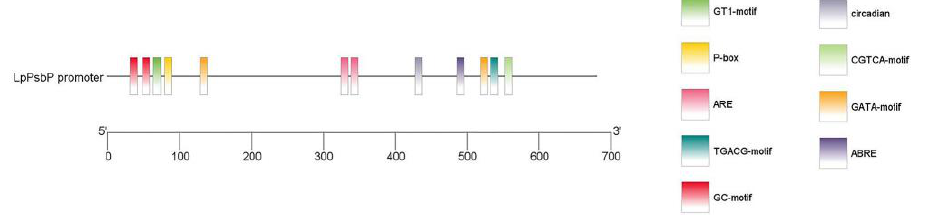
Figure 7. Visual analysis of the LpPsbP promoter. The acquired promoter sequences underwent vis- ual analysis using the TBtools software to present some cis-acting elements such as GT1-motif and P-box. Sequence analysis revealed that this sequence comprised numerous responsive and regula- tory regions. Table 3. Analysis of cis-acting elements in the promoter sequence of LpPsbP gene.